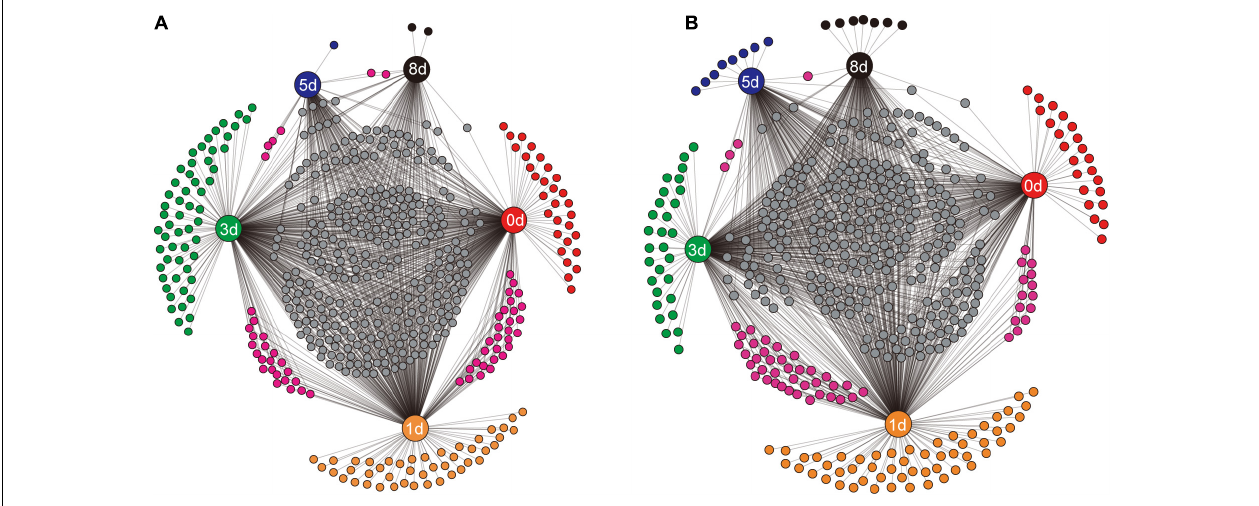
FIGURE 5 | The shared genera between different sampling times and the unique genera at a specific sampling time in native soil treatment (A) and non-native soil treatment (B) . The sampling times (days 0, 1, 3, 5, and 8) are indicated by the nodes with labels. Each unlabeled node represented an individual genus. Connections (black lines) were drawn between specific sampling time and the related